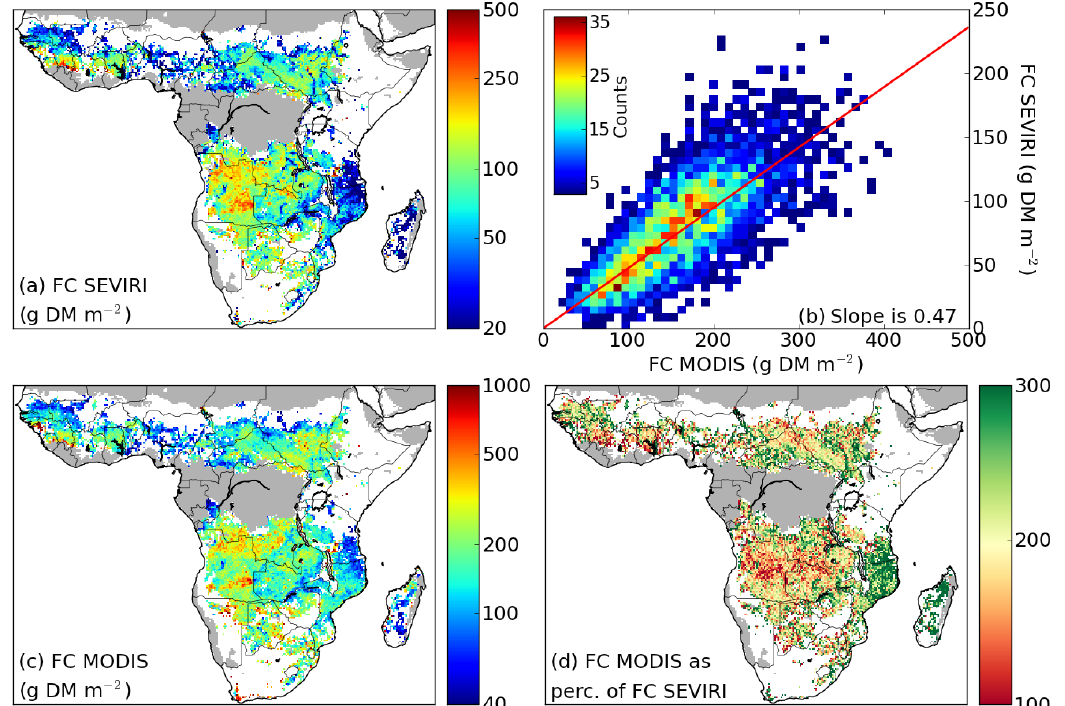
Figure 2. Comparison of fuel consumption (FC) estimates derived by combining FRP and burned-area data. (a) Fuel consumption derived using SEVIRI FRP data. (b) Correlation between fuel consumption estimates based on the SEVIRI and MODIS FRP data. (c) Fuel con- sumption derived using MODIS FRP data. (d) MODIS-based fuel consumption estimates as a percentage of the SEVIRI-based estimates. For comparison both SEVIRI- and MODIS-based estimates are shown for the same period (2010–2014) and the MODIS FRE data are un- corrected (see Sect. 4.2). Note that on average MODIS-derived FC is about twice as large as SEVIRI-derived FC. Grid cells with dominant land cover “forest” or “bare or sparsely vegetated” were excluded from our analysis and are masked grey, while water and grid cells with less than 50 MODIS FRP detections are shown in white in all